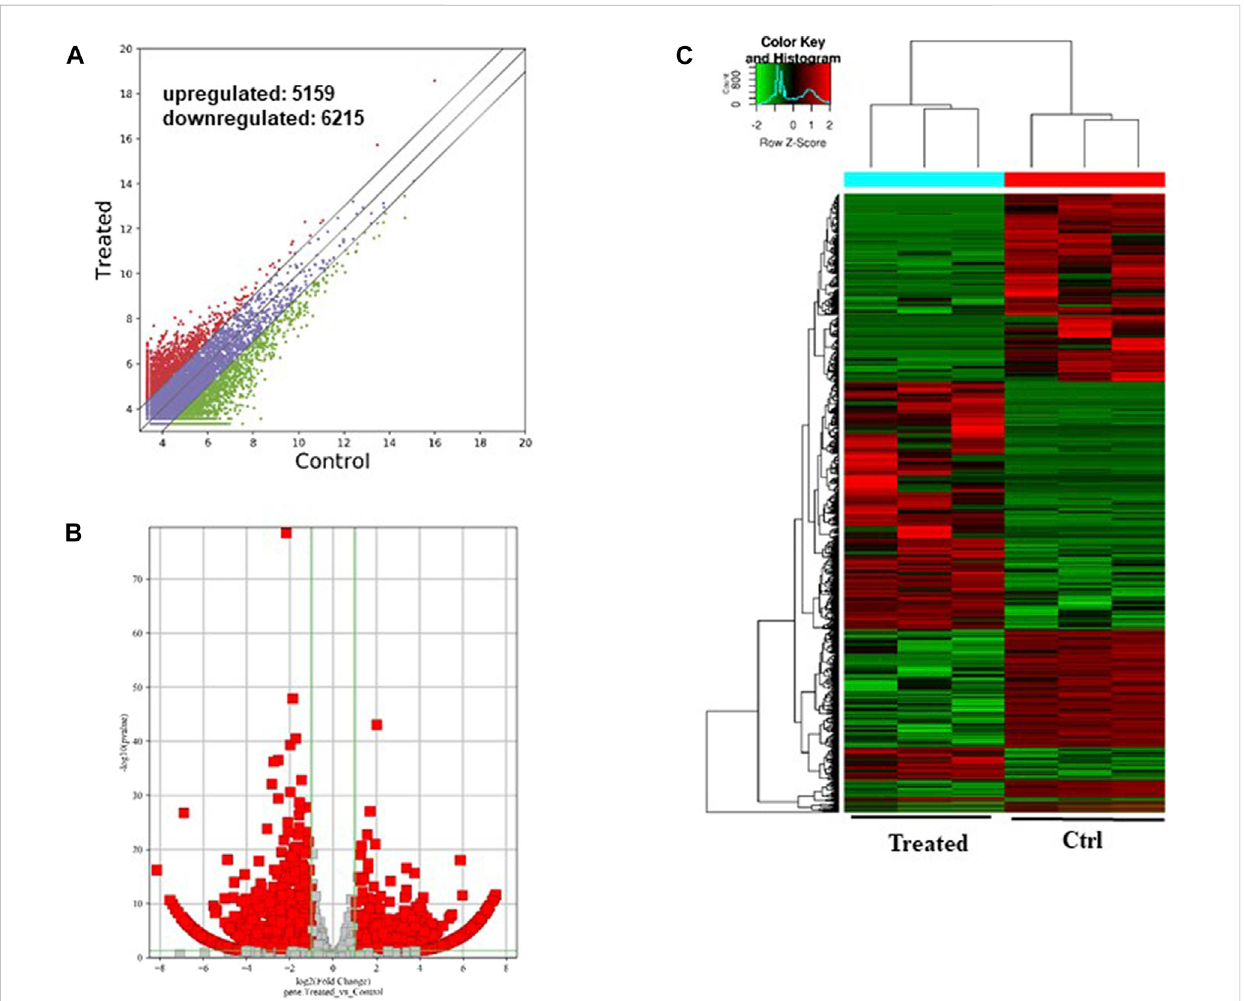
FIGURE 6 Differentially expressed mRNAsintheGO-AgNPstreatedcaprinefetal fi broblastcells(CFFCs). (A) HierarchicalclusteranalysisofmRNAsinthecells. The mRNAs with the red points and blue points indicate > 2.0 fold changes between control and treated cells. (B) Volcano plots were constructed using fold-change values and p -values. The red and blue points represent the differentially up- and downregulated mRNAs with statistical signi fi cance (fold- changes of > 2 and p -values of < 0.05). (C) Clustered heatmap of differentially expressed mRNAs in the